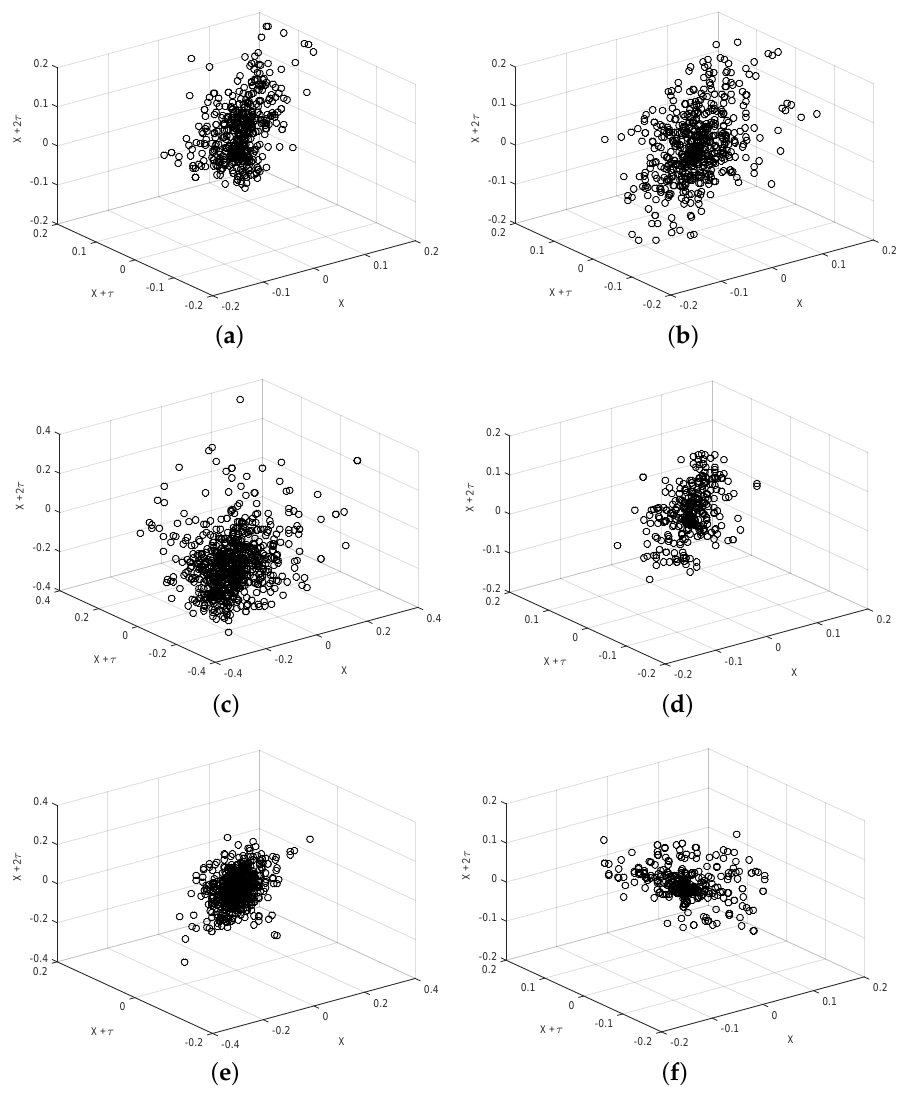
Figure 6. Reconstructed Phase Space (RPS) with basic activities. ( a ) A1; ( b ) A2; ( c ) A3; ( d ) A4; ( e ) A5; and, ( f )